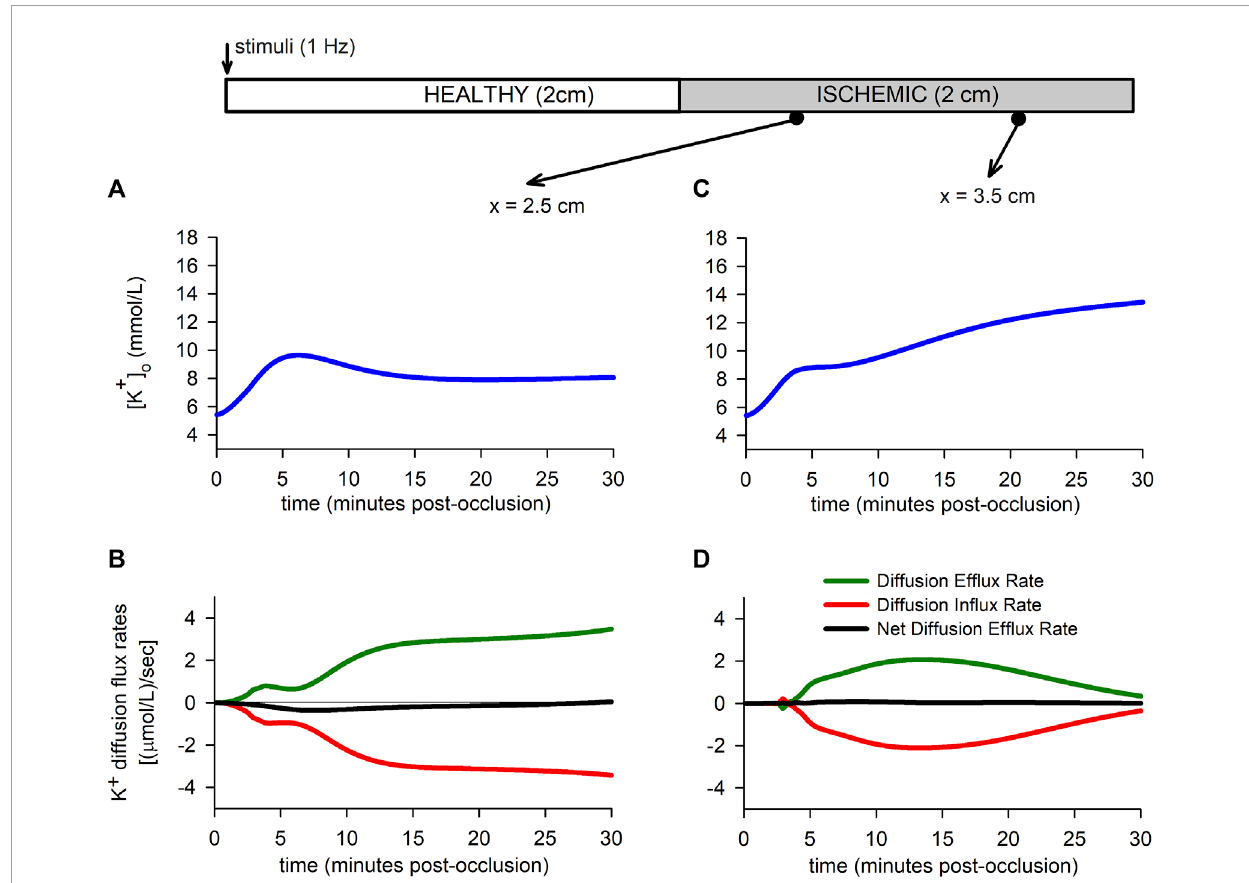
FIGURE 7 Extracellular potassium flux rates. (A,B) : Extracellular potassium accumulation [Panel (A) ] and extracellular potassium diffusion flux rate [Panel (B) ] for a point located in the BZ. (C,D) : Extracellular potassium accumulation [Panel (C) ] and extracellular potassium diffusion flux rate [Panel (D) ] for a point located in the